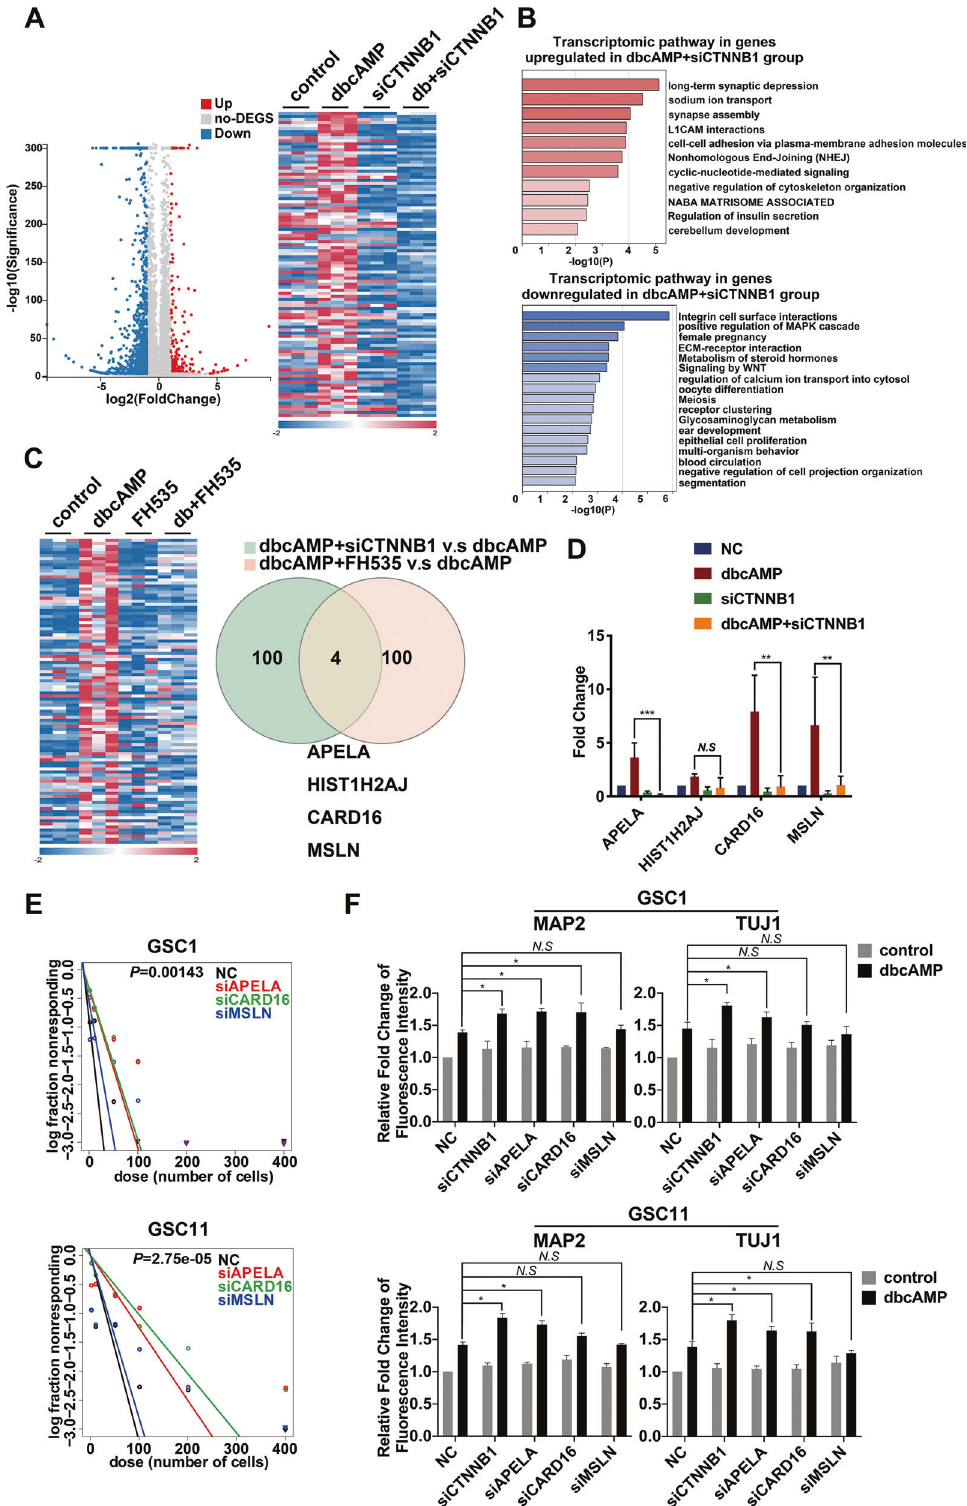
Fig. 6 Identi fi cation of β -catenin downstream genes that contribute to the negative regulation of cAMP-induced differentiation in GSCs. A Volcano plot and heat map show the distribution of DEGs in dbcAMP-treated GSCs before and after the knock-down of β -catenin. B Function and pathway enrichment of DEGs in dbcAMP-treated GSCs before and after the knock-down of β -catenin. C Heat map and Venn diagram demonstrating the overlap of top downregulated DEGs in the two gene sets. D Validation of the expression of four DEGs by using qRT-PCR. E Limiting dilution assays of GSC1 and GSC11 cells after treatment with speci fi c siRNA targeting APELA, CARD16 and MSLN. F Quanti fi cation of MAP2 and TUJ1 in GSCs treated with the combination of dbcAMP and knock-down of CTNNB1, APELA, CARD16 or MSLN, by using fl ow cytometry. (db, dbcAMP; Data are shown as the mean ± SD. N.S., not signi fi cant; *, p < 0.05; **, p < 0.01; ***, p < 0.001).